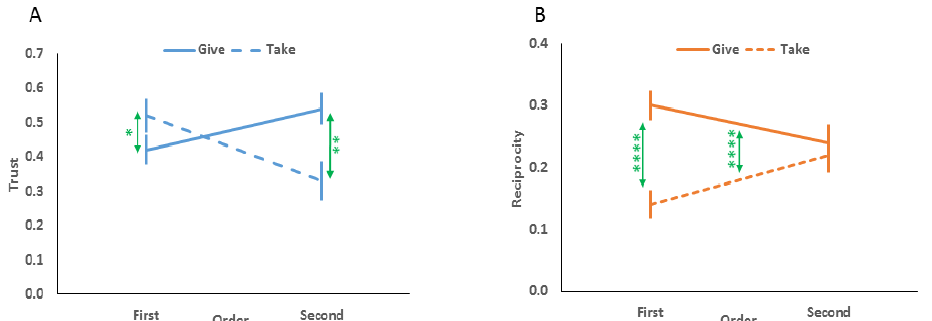
Figure 1. Framing effects on trust and reciprocity. ( A ). Trust. Comparing the first decision between trustor groups (Give-Frame [G-Frame], Take-Frame [T-Frame]) revealed higher trust in T- than G- Frame, whereas comparing the second decision showed higher trust in G- than T-Frame. The overall framing effect for trust disappeared when frames were compared for both decisions based on the reverse framing effects for the first and second trust decisions. ( B ). Reciprocity. Comparing the first decision between trustee groups (G-Frame, T-Frame) demonstrated more reciprocity in G- than T- Frame, but comparing the second decisions showed similar reciprocity for both frames. The overall framing effect for reciprocity remained intact, driven by the framing effect of the first decision. * p < 0.05, ** p < 0.01, **** p < 0.001, green color: framing effect. Next, a 2 × 2 analysis of variance (ANOVA) separately for each of trust and reciprocity decisions was conducted with Frame (G, T) as a within-subjects factor and Order (G-T, T-G) as a between-subjects factor. For trust decisions, the ANOVA revealed a significant main = 0.08) but no main effect of Frame ( F (1,81) = 1.10, effect of Order ( F (1,81) = 7.53, p < 0.01, η 2 p